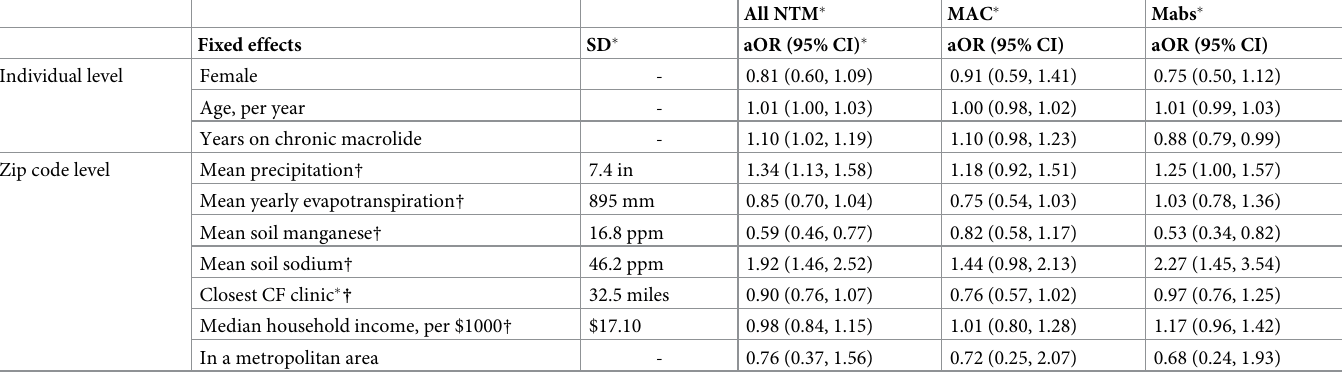
Table 3. Generalized linear mixed models with a binomial distribution and a random intercept for zip code of demographic and environmental risk factors for NTM culture positivity in persons with cystic fibrosis, Florida, 2011–2017.